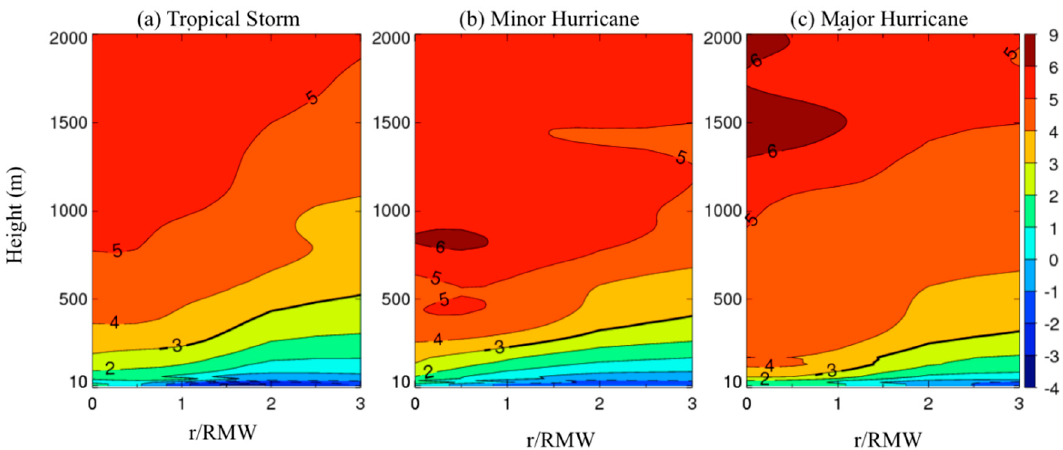
Figure 8. Composite analysis of the lapse rate of virtual potential temperature (in K km − 1 ) as a function of altitude and normalized radius for ( a ) tropical storms, ( b ) minor hurricanes, and ( c ) major hurricanes. The thick black line represents the contour of d θ v / dz = 3 K km − 1 . The contour interval is 1 K km − 1 in all panels.